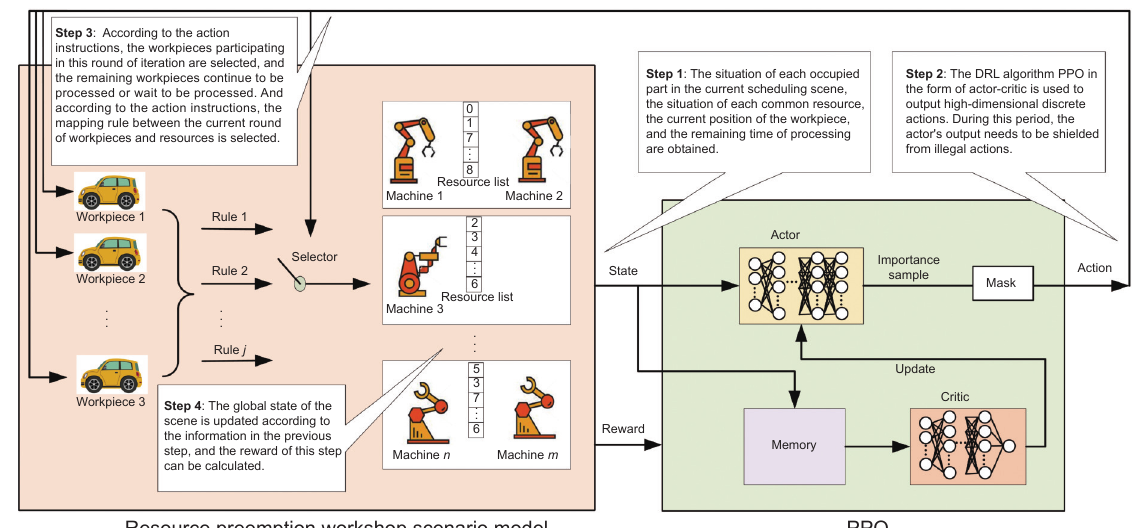
Fig. 1 PPO-based two-layer rule scheduling algorithm